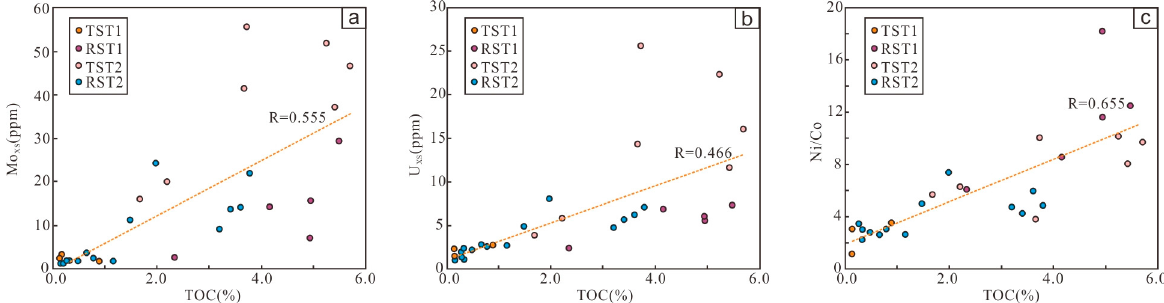
Figure 6. Crossplots of TOC vs. ( a ) Mo XS , ( b ) U XS , and ( c ) Ni/Co of samples from Well SY1.